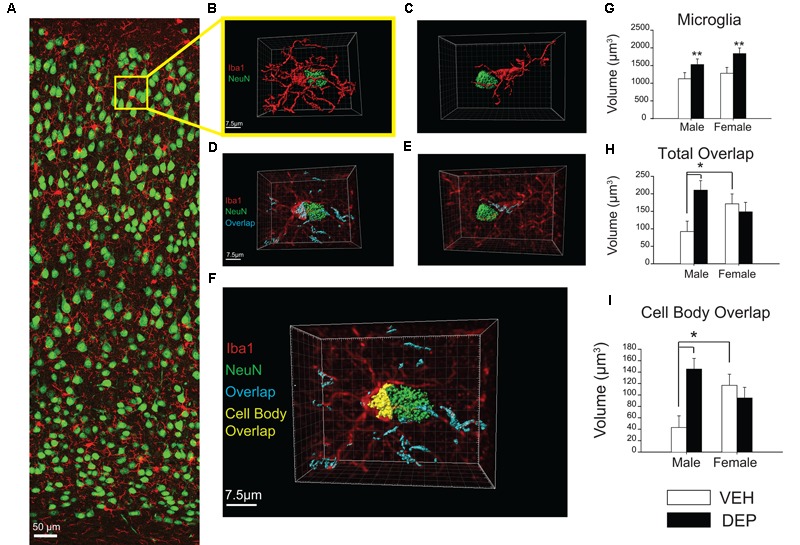
Increased overlap between microglia and neurons in juvenile offspring prenatally exposed to DEP. (A) Representative panoramic image of microglia (Iba1, red) and neurons (NeuN, green) in the parietal cortex of a P30 DEP-exposed female taken at 40× magnification and stitched together with 30% overlap. (B) Example 3D surface rendering of microglia-neuron apposition, imaged by confocal microscopy at 100× magnification and reconstructed following a previously published protocol (Schafer et al., 2012, 2014). Neurons and microglia not involved in the microglia-neuron interaction were removed for clarity. (C) Example of microglia-neuron apposition that was excluded from analysis post-reconstruction due to lack of direct cell body contact. (D,E) 3D surface renderings of neurons (NeuN, green) and microglia-neuron overlapping regions (cyan). In these images, 3D reconstructed microglia appear in translucent red to allow visualization of overlapping material within microglia. Note: neurons not directly contacting the microglial cell body were removed for clarity but overlapping regions between microglial processes and these extraneous neurons were quantified as part of total overlap between microglia and neurons. (F) 3D reconstruction of microglia-neuron apposition including total overlapping material (cyan) and cell-body overlap (yellow). (G) Quantification of microglial cell volume. Analysis of reconstructed microglial volume revealed DEP-exposed offspring have larger microglia volumes than those exposed to VEH. (H) Quantification of total microglia-neuron overlap. Total overlap includes overlapping material between microglial processes and any surroundings neurons, as well as cell body-cell body overlap. Analysis of the total volume of Iba1-NeuN overlap revealed a significant Sex X DEP interaction, which is driven by a larger overlap volume in DEP males vs. VEH males, as well as a larger overlap volume in VEH females vs. VEH males. (I) Quantification of cell body overlap. Cell body overlap is restricted to overlap between one microglia and one neuron, and just between the cell bodies of these two cells. Analysis of cell body overlap revealed a significant Sex X DEP interaction, which we determined to be due to a larger volume of cell body overlap in DEP males vs. VEH males, as well as in VEH females vs. VEH males. Bar graphs represent mean values ± SEM (error bars); n = 3 mice/group, 3–5 microglia-neuron renderings per mouse. The data were log-transformed for analysis due to unequal variance, but are displayed as raw data in the figures. Grid line increments = 2.5 μm. ##p < 0.05, males vs. females; ∗∗p < 0.05, DEP vs. VEH; ∗p < 0.05, vs. VEH male.